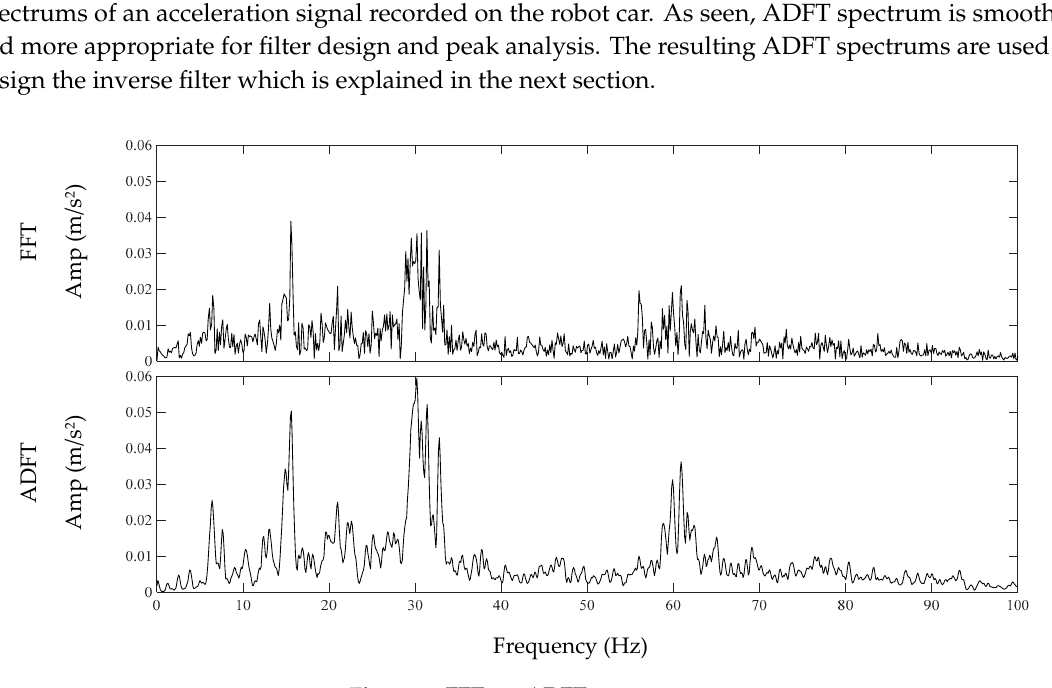
Figure 1. FFT vs. ADFT spectrums.